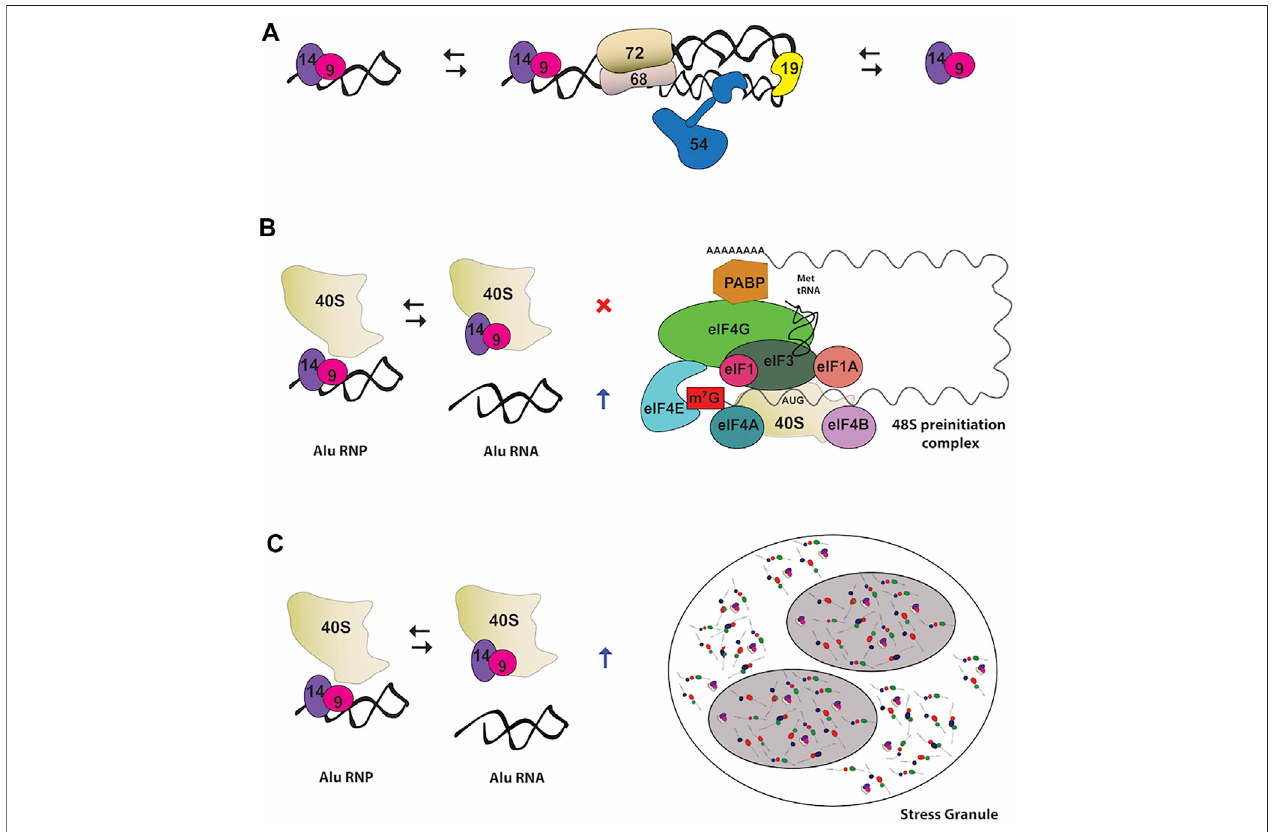
FIGURE3| NoncanonicalfunctionsoftheheterodimerSRP9/14 (A) Inprimatecells,SRP9/14existsaspartoftheSRPcomplex,aswellasfreeproteinandinRNP complexes with 7SL RNA-derivatives RNA, such as Alu RNA (B) Role of Alu RNP in regulating translation. Alu RNPs interfere with the formation of 48 S preinitiation complex by SRP9/14 binding to the ribosomal subunit 40 S. On the other hand, free Alu RNA stimulates translation by sequestering SRP9/14 (C) Role of Alu RNP in stress granules (SGs) assembly. SRP9/14 localizes to SGs through binding with the ribosomal subunit 40 S. Binding of SRP9/14 to 40 S and Alu RNA is mutually